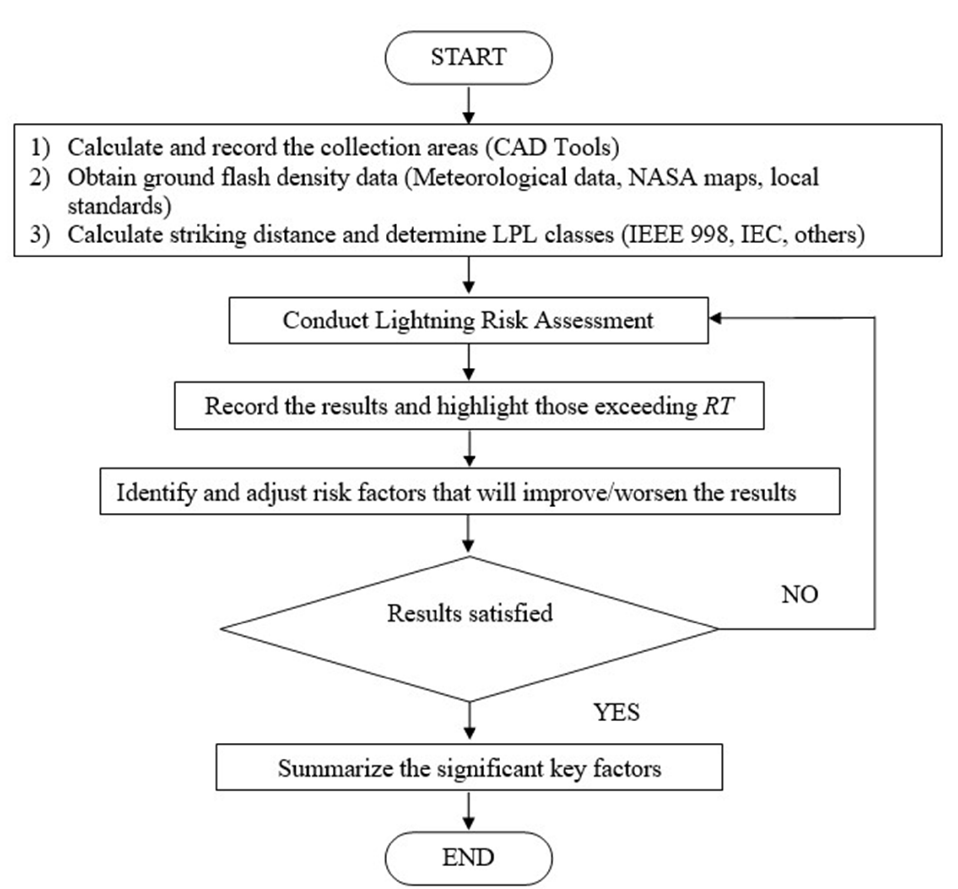
Figure 2. Integrated Process of Lightning Risk Assessment.